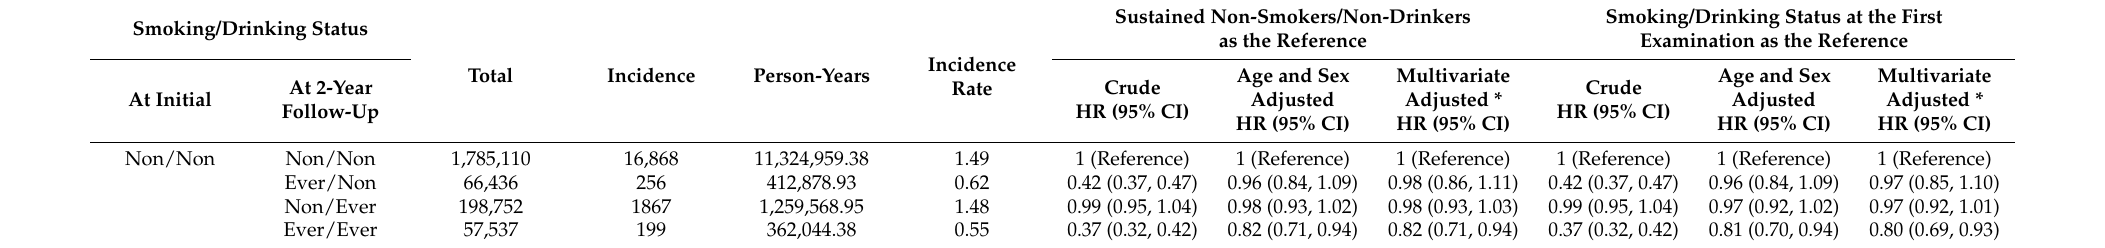
Table 4. Changes in smoking and alcohol intake on thyroid cancer